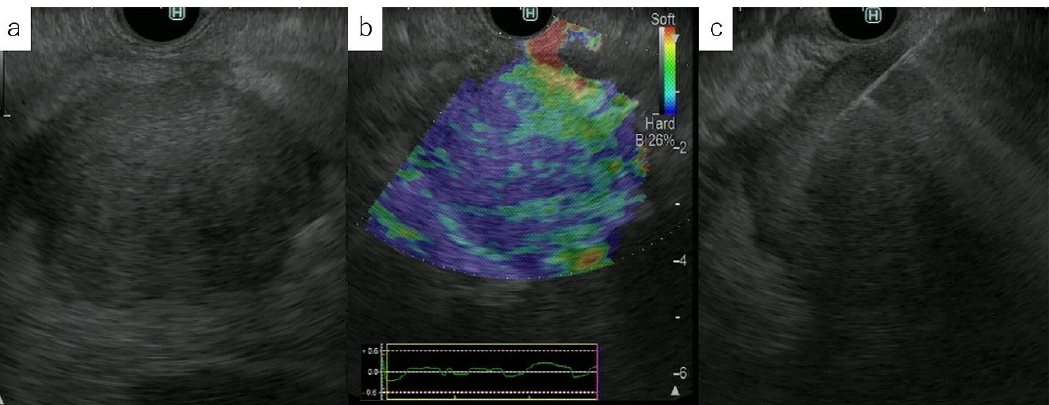
Figure 2. Targeting EUS-FNA with EUS-elastography. ( a ) Fundamental B mode endoscopic ultrasonogram showing a low echoic mass. ( b ) EUS-elastography image showing no distortion on low echo area and surrounding tissue. ( c ) EUS-FNA with EUS-elastography targeting the harder area.